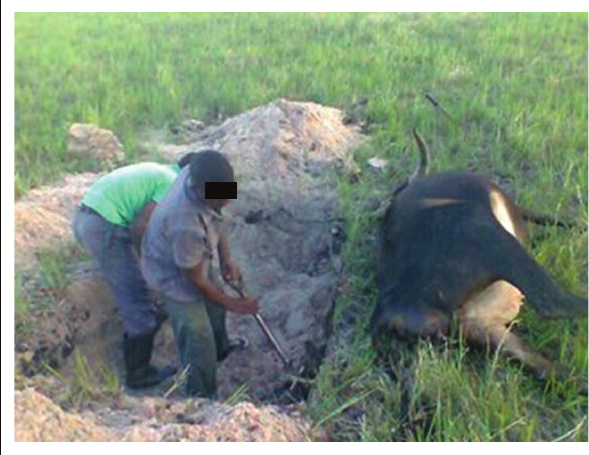
FIGURE 3: Community members burying anthrax carcass in grazing